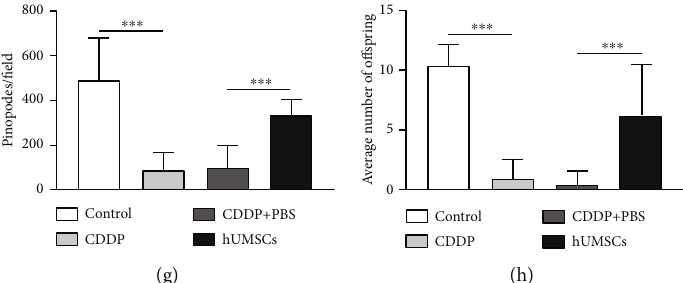
Figure 2: Changes of ER, PR, and receptivity in endometrium. (a) Immunohistochemical staining was used to observe the expressions of ER and PR in uterine tissues of each group (200 × ). (b) Intensities of ER and PR staining within each group as quanti fi ed using ImageJ. (c) Representative examples of HOXA10 staining within uterine tissue in each group (200x). (d) Intensities of HOXA10 staining within each group as quanti fi ed were using ImageJ. (e) Pinopodes as observed with use of scanning electron microscopy (1.00KX, 3.00KX). (f) Fertility rates of rats in each group. (g) Summary of total numbers of endometrial pinopodes per fi eld. (h) Summary of the average number of litter sizes in each group. Data are presented as the means ± SDs . ∗ P < 0 : 05, ∗∗ P < 0 : 01, and ∗∗∗ P < 0 : 001 . CDDP: cisplatin; ER: estrogen receptor; PR: progesterone receptor; HOXA10: homolobox